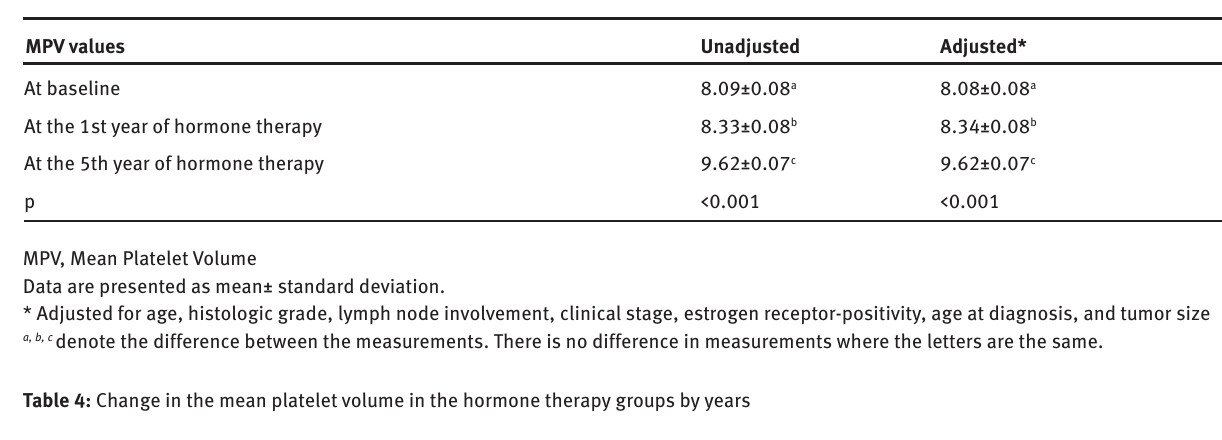
MPV values Unadjusted At